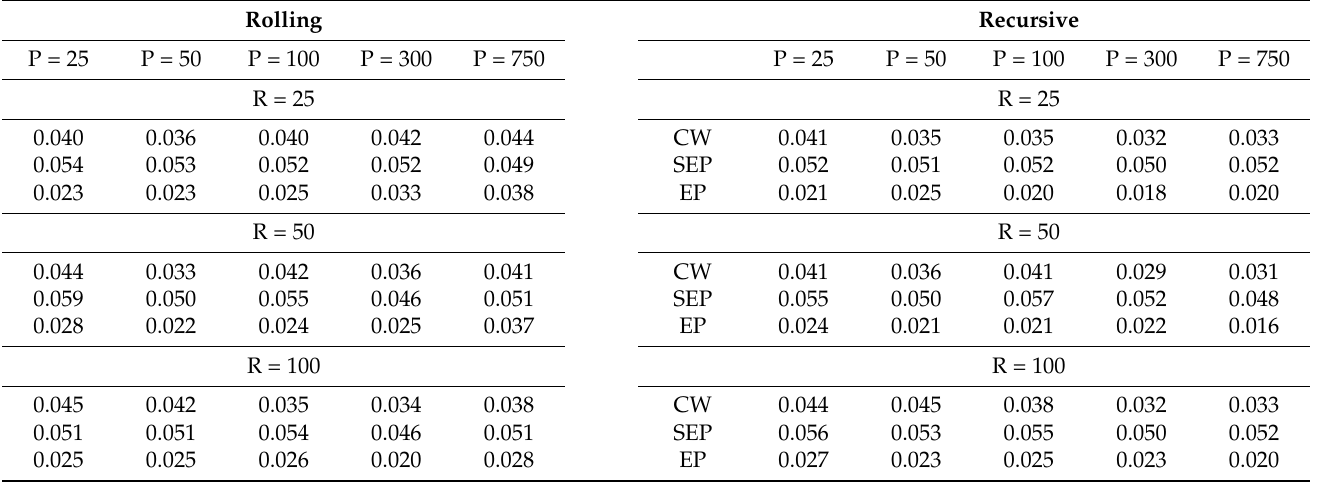
Table A2. Empirical Size DGP2 (Nominal Size of